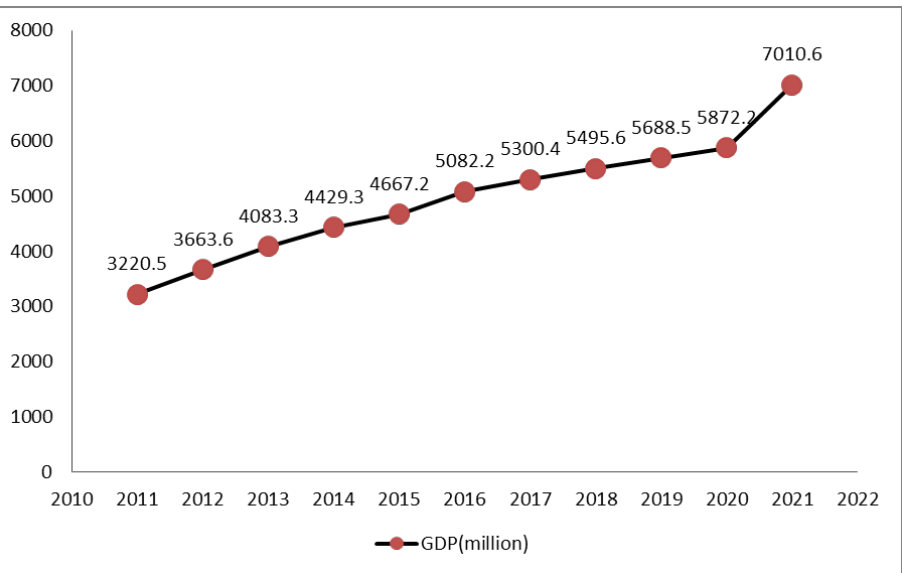
Figure 10. GDP of Weifang from 2011–2021 (Source: own drawing; Data source: http://tjj.weifang.gov.cn/TJYW/TJSJ/NDSJ/202209/t20220909_6105568.htm. Format: accessed on 12 September 2022).